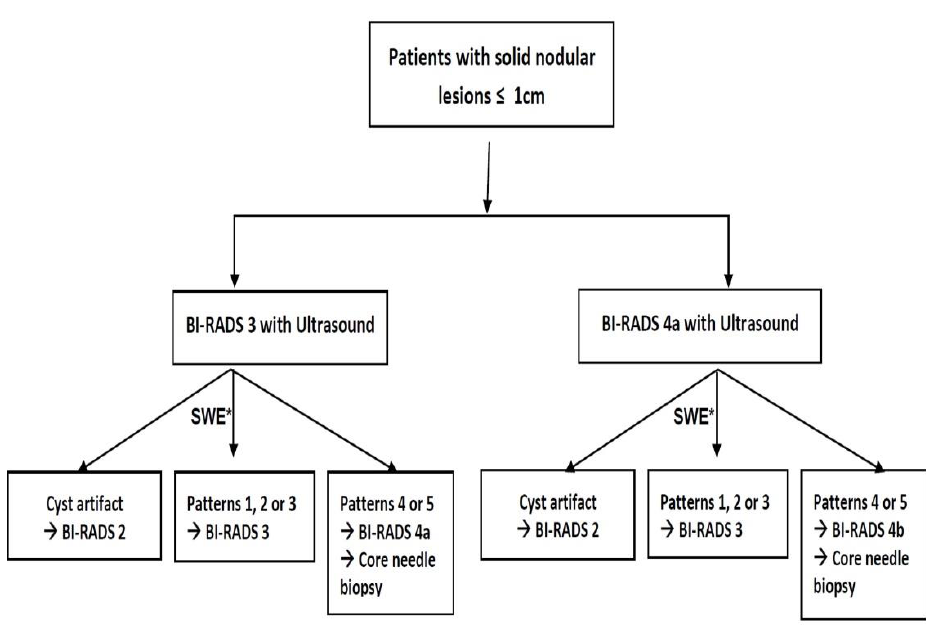
Figure 3. Management algorithm proposed. * Shear wave elastography.